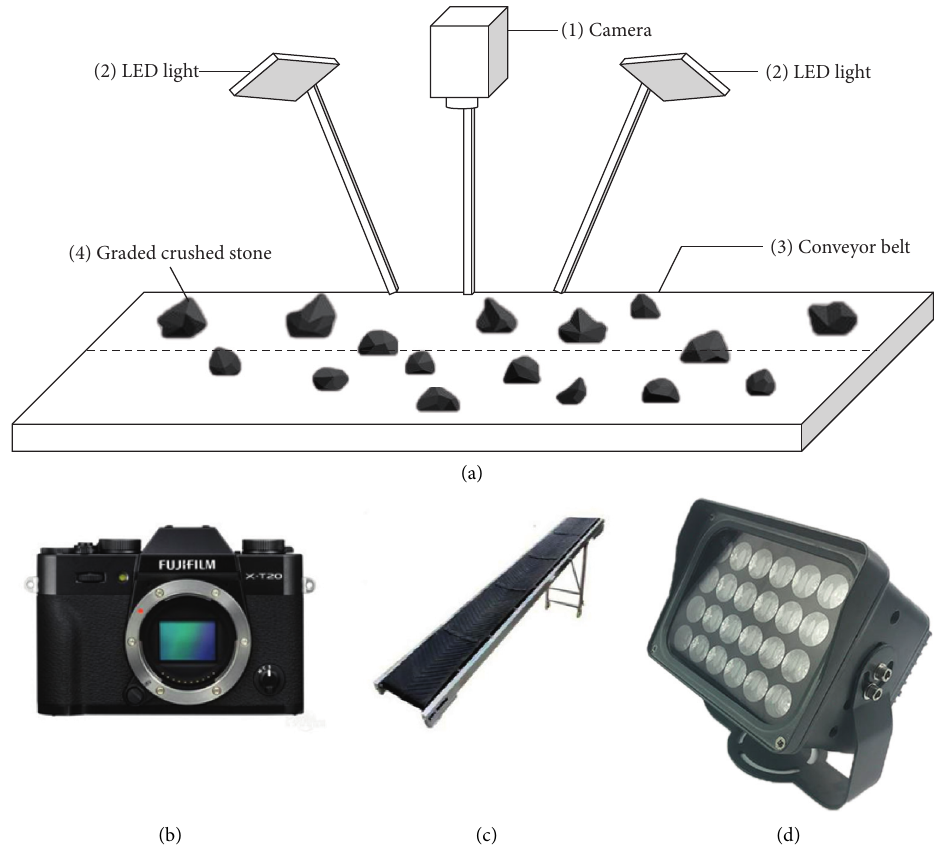
Figure 1: Materials and equipment for GCS images capture. (a) The equipment to photograph GCS. (b) Fujinon camera. (c) Conveyor belt. (d) LED